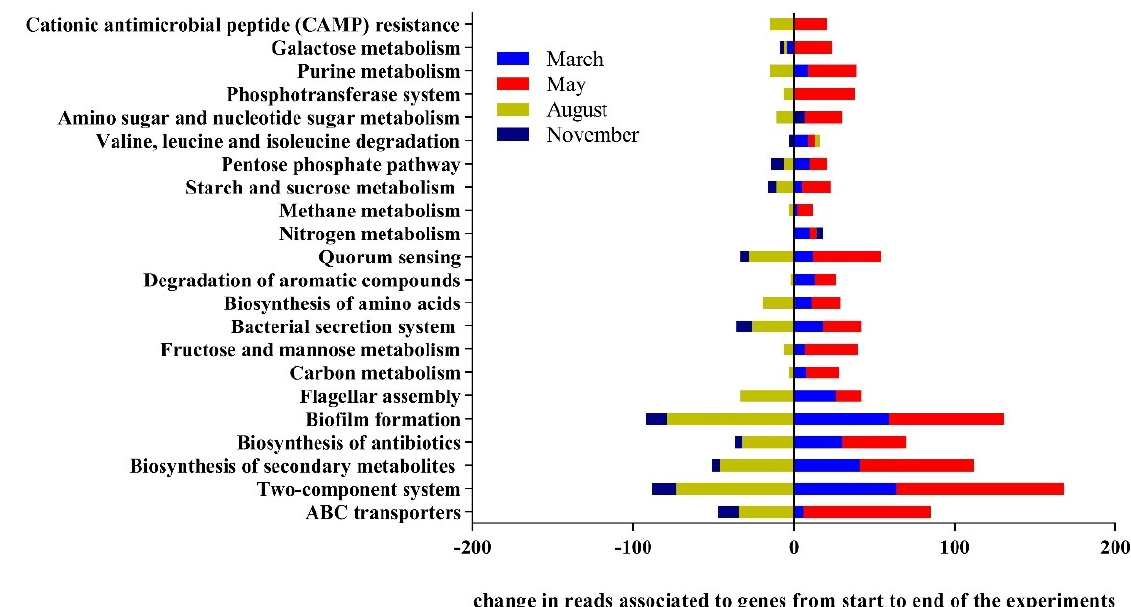
Figure A3. Changes in the gene abundance (KEGG Orthology (KO) abundance) summarized for different metabolic pathways from the start to the end of the incubation based on functional predictions using the program Tax4Fun.